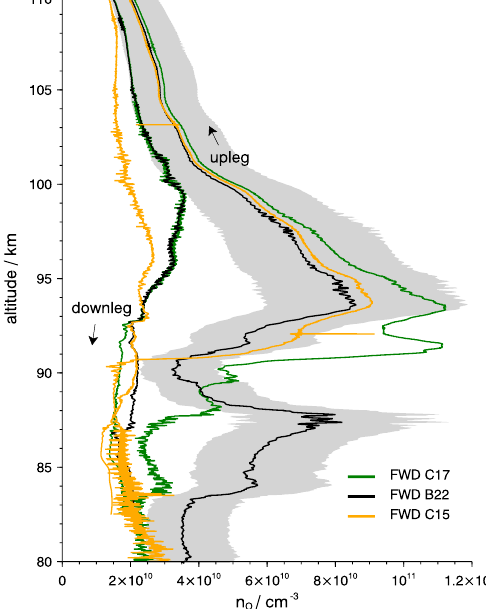
Figure 11. Measurement results for atomic oxygen number density vs. altitude for sensors on the fore deck during the up- and downleg without aerodynamic correction. The shading shows the uncertainty from the calibration for fore sensor